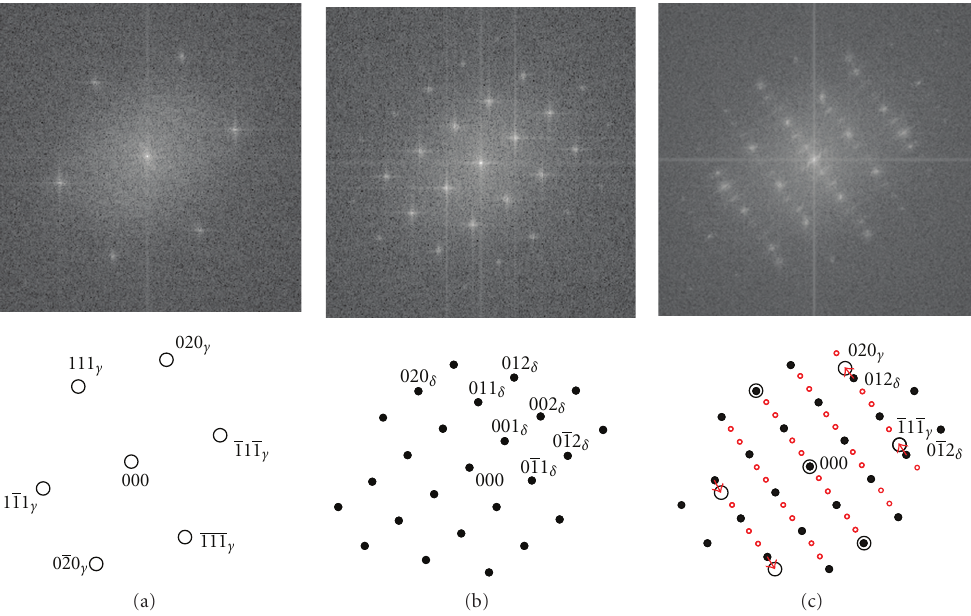
Figure 11: Fourier transform of zones a, b, and c in Figure 10 (first row) and their indexing (second row).